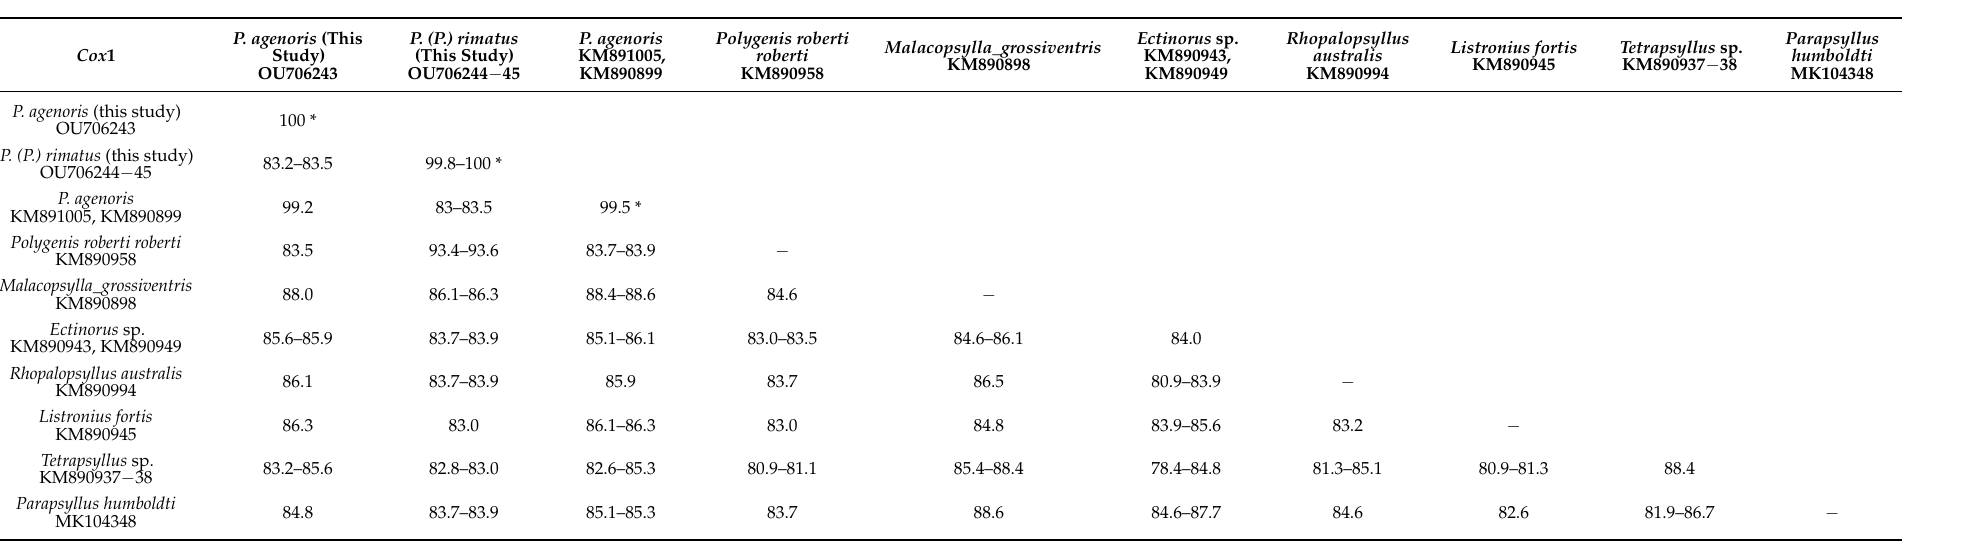
Table 3. Intraspecific (*) and interspecific similarities observed among all partial cox1 mtDNA gene sequences of P. agenoris and P. (P.) rimatus (obtained in this study) and different species and genera belonging to Rhopalopsyllidae and Malacopsyllidae families retrieved from GenBank database. Values are given in